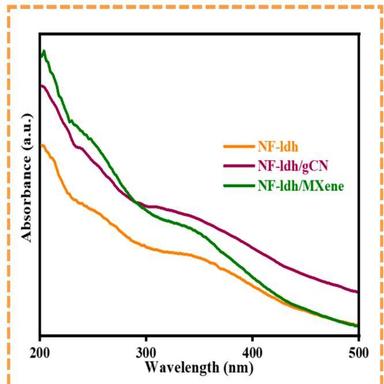
UV–visible absorption spectra of synthesized nanoparticles.